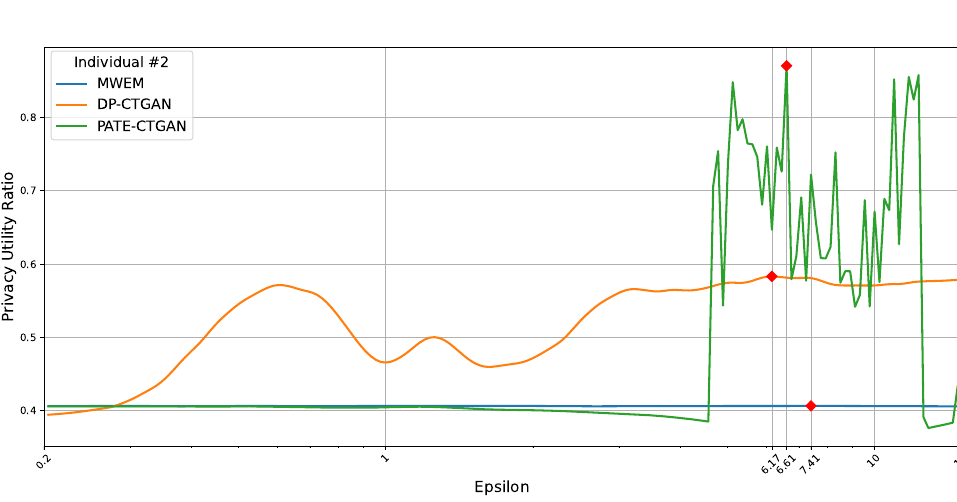
Figure 6. Plot of the privacy–utility ratio for an individual using MWEM, DP-CTGAN, and PATE-CTGAN at 20 runs. The red diamonds show the (cid:101) value at which the best trade-off between privacy and utility for each technique is